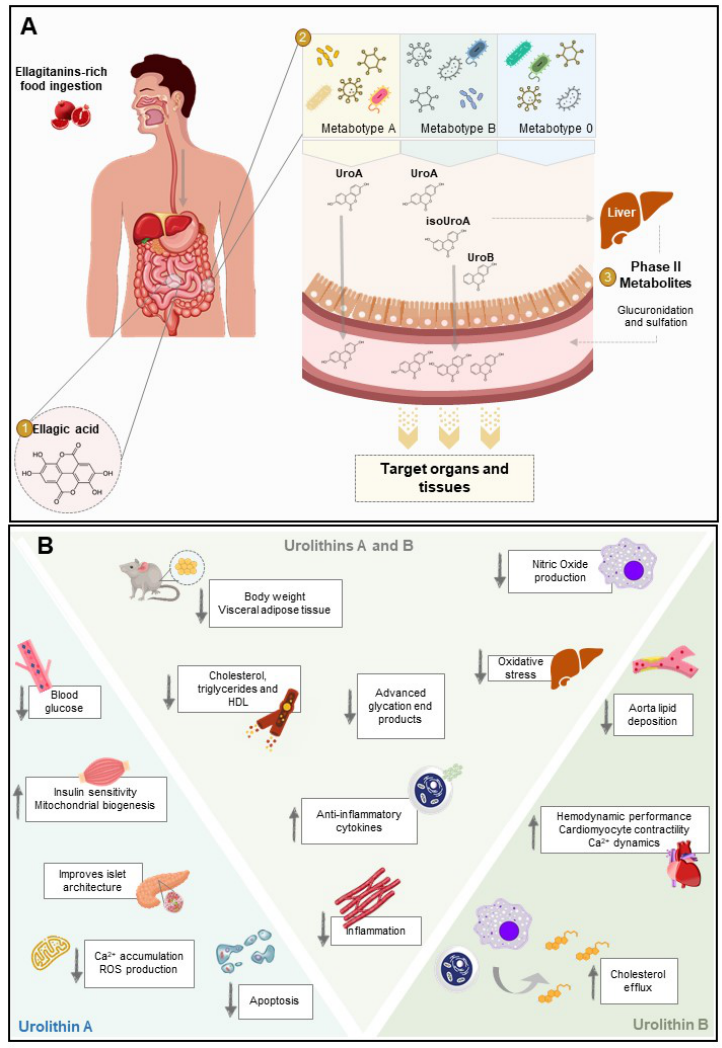
Figure 2. Metabolism of ellagitannins to yield bioactive urolithins with potential action for diabetes. ( A ) Several dietary products (e.g., pomegranate) are rich in ellagitannins (ETs), a class of natural (poly)phenols. Upon ingestion, ETs are hydrolyzed in the small intestine into ellagic acid (EA), reaching the colon. Through the action of microbiota, EA is converted to urolithins depending on the individual’s metabotype. In phase-II metabolism, urolithins are further modified by large intestine enterocytes and the liver (methylation, glucuronidation, and sulfation) to yield conjugated forms of these metabolites. Both conjugated and deconjugated urolithins are able to enter circulation and reach the target tissues where they will perform their function. Although conjugated forms are often found at higher concentrations than the respective deconjugated counterparts, aglycones show much higher bioactivity. ( B ) Once absorbed by the target tissues, urolithin A and urolithin B may exert cell-specific activities that confer protection towards a multitude of diabetes complications. In mice, urolithin A decreases blood glucose and increases glucose tolerance and insulin sensitivity. It also protects against islet architecture disruption, oxidative stress, and cell death. Urolithin B is described to reduce lipid deposition in the aorta and increase cholesterol efflux on macrophages cell lines. In adult Wistar rats with streptozotocin-induced diabetes, urolithin B prevents the negative impact of altered diabetic milieu on cardiac performance. Regarding the common effects, urolithin A and urolithin B influence lipids levels. They reduce body weight and fat mass in high fat diet-fed mice and decrease the amounts of cholesterol, triglycerides, and high-density lipopolysaccharide (HDL) in serum. Urolithin A and urolithin B also protect cells from inflammatory response and oxidative